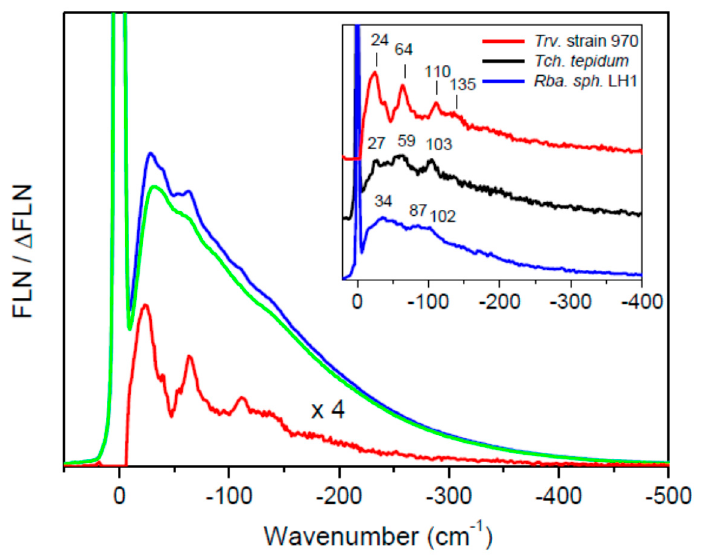
Figure 3. The ∆ FLN spectrum (red line) of the Ca-LH1-RC complex from Trv . 970 at 4.5 K presented in relative wavenumber scale. The four-fold amplified spectrum recorded with a resolution of 6 cm –1 was excited at 1004.0 nm. The intense zero-phonon line at the origin is cut off for clarity. Blue and green curves denote the corresponding pre- and post-burn FLN spectra recorded with fluencies of 16 mJ/cm 2 . The post-burn spectrum is measured after the intermediate hole-burning stage (hole-burning fluence of 830 mJ/cm 2 ). The inset compares the area-normalized ∆ FLN spectra of the samples studied. Vertical lines label selected vibrational mode frequencies. The spectra are vertically shifted relative to each other for better visibility.